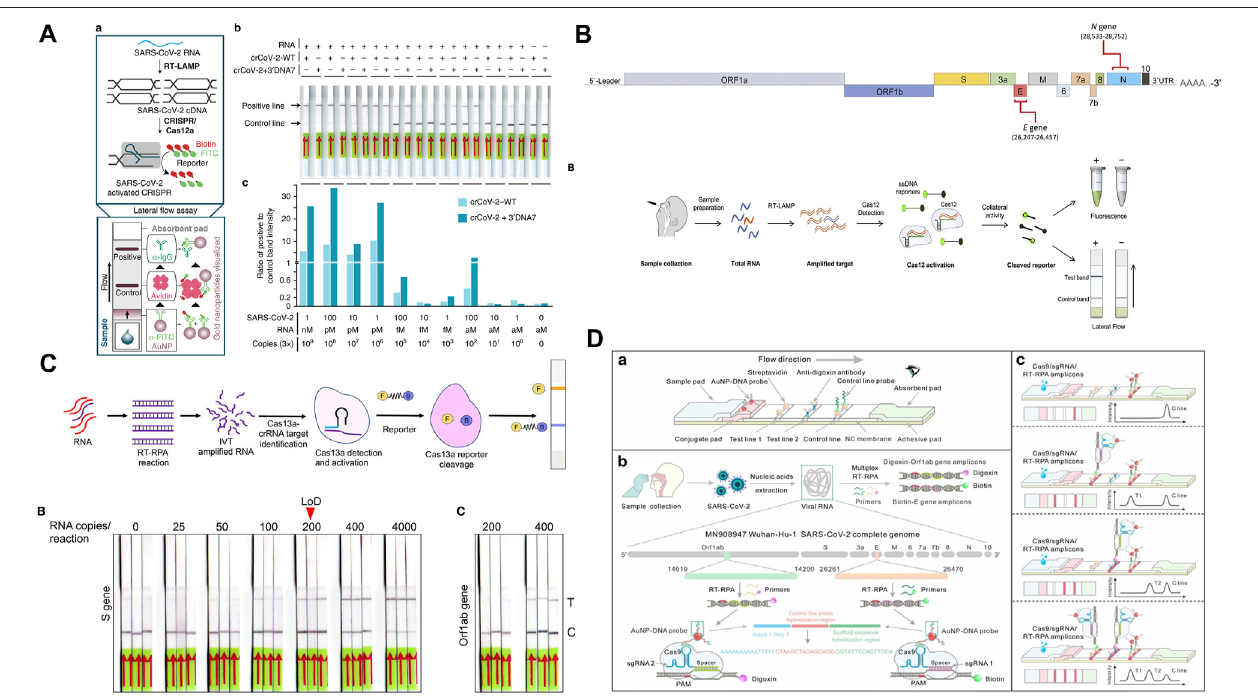
FIGURE 5 | (A) Cas12-based ENHANCE method with RT-LAMP ampli fi cation. Adapted with permission from (Nguyen et al., 2020) under Creative Commons license; (B) CRISPR – Cas12a-based iSCAN assay. Adapted with permission from (Ali et al., 2020a) under Creative Commons license; (C) Cas13a-based lateral- fl ow assay.Adaptedwithpermissionfrom(Azmietal.,2021)underCreativeCommonslicense; (D) CRISPR/Cas9-mediatedlateral fl owassay.Adaptedwithpermissionfrom (Xiong et al., 2021) copyright Wiley-VCH